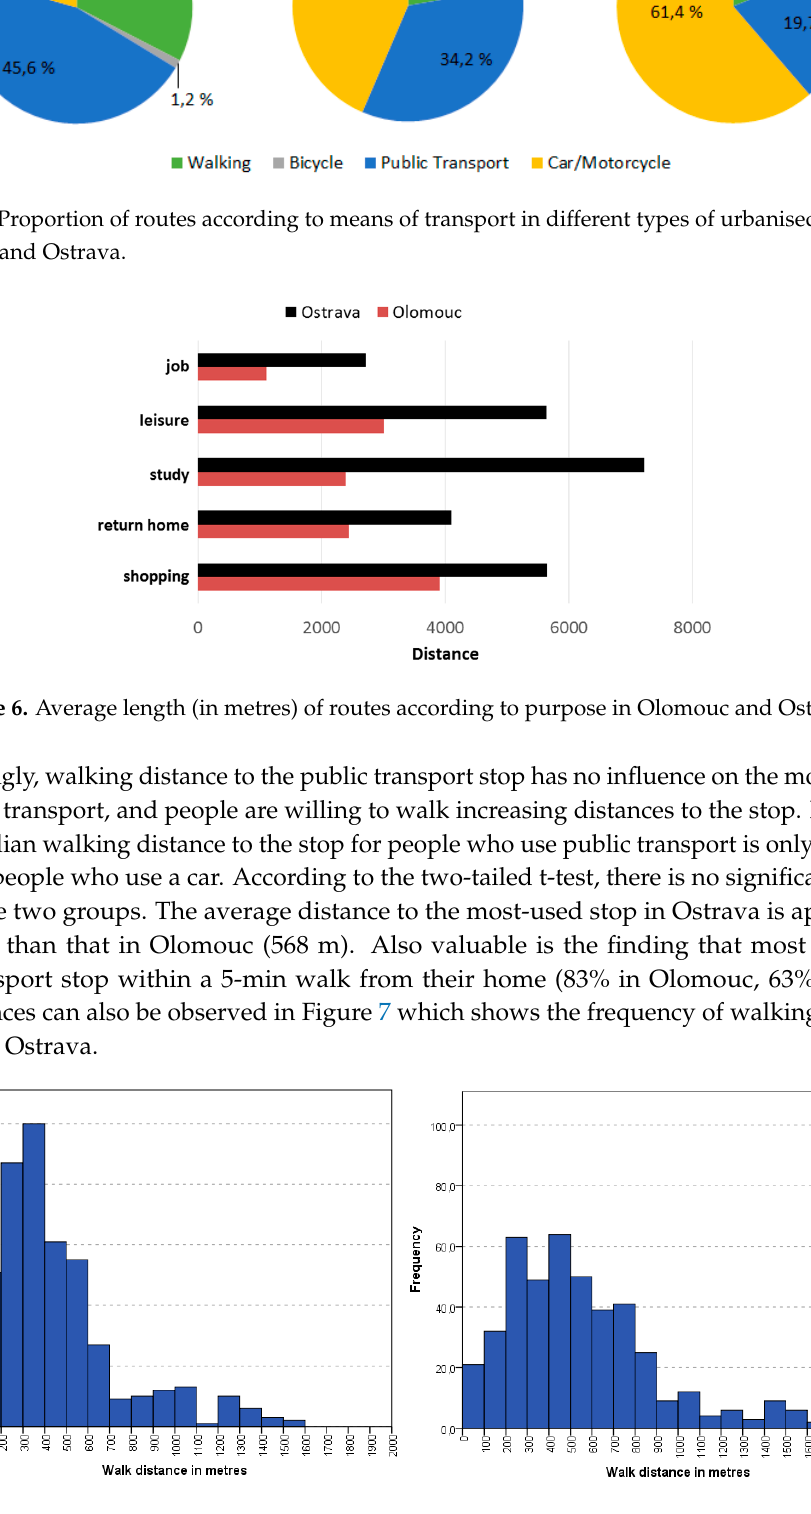
Figure 7. Walking distance to a preferred stop in Olomouc ( left ) and Ostrava ( right ).